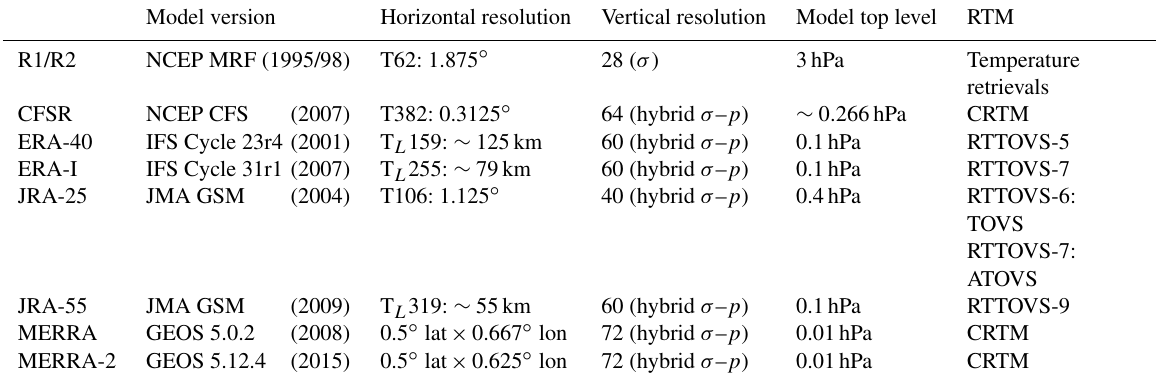
Table 1. Information about NCEP, JMA, ECMWF, and GMAO earlier and latter reanalyses pertinent to the stratosphere. Information includes the model version, horizontal and vertical resolution, model top pressure, and radiative transfer model (RTM)